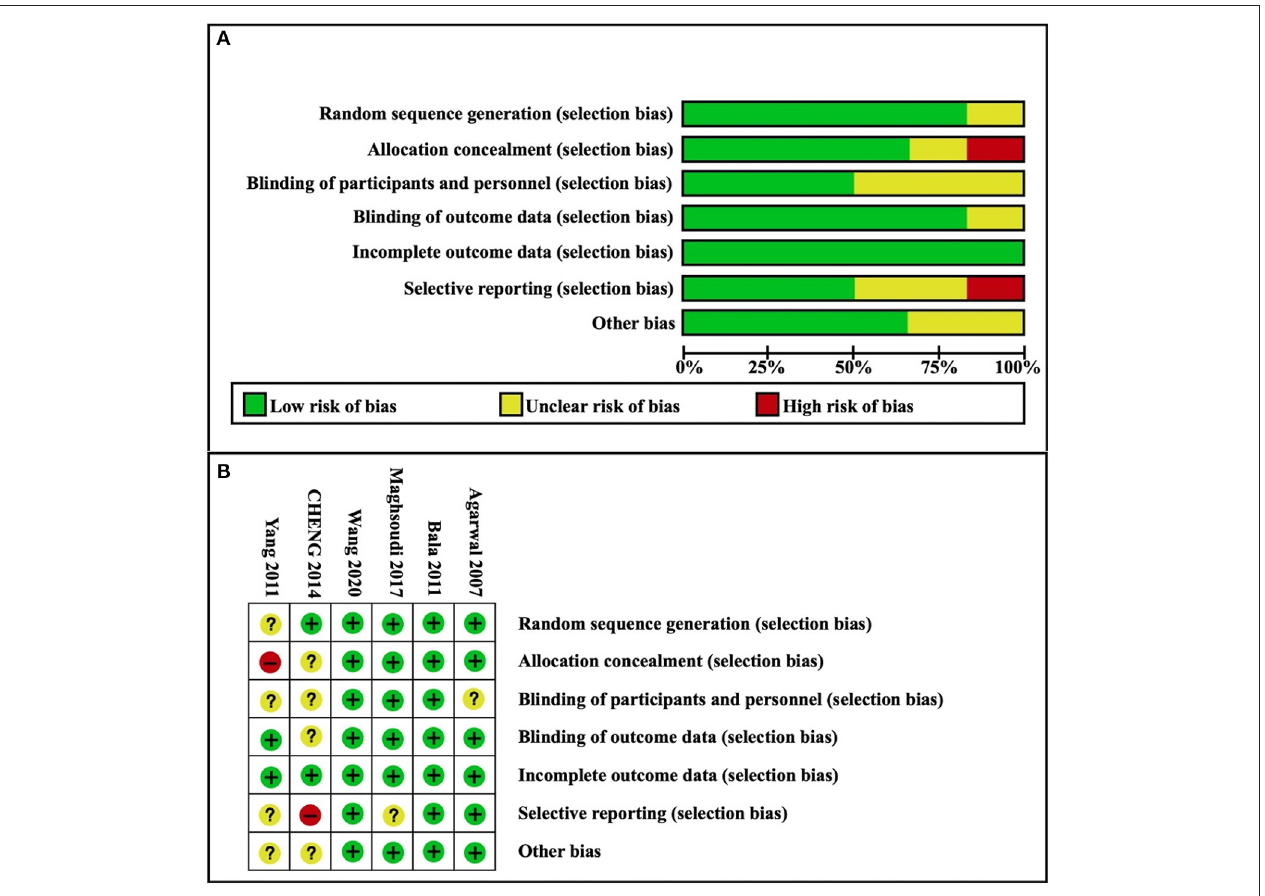
FIGURE 2 | Risk of bias. (A) Risk of bias graph; (B) Risk of bias summary. Green = low risk of bias; yellow = unclear risk of bias; red = high risk of